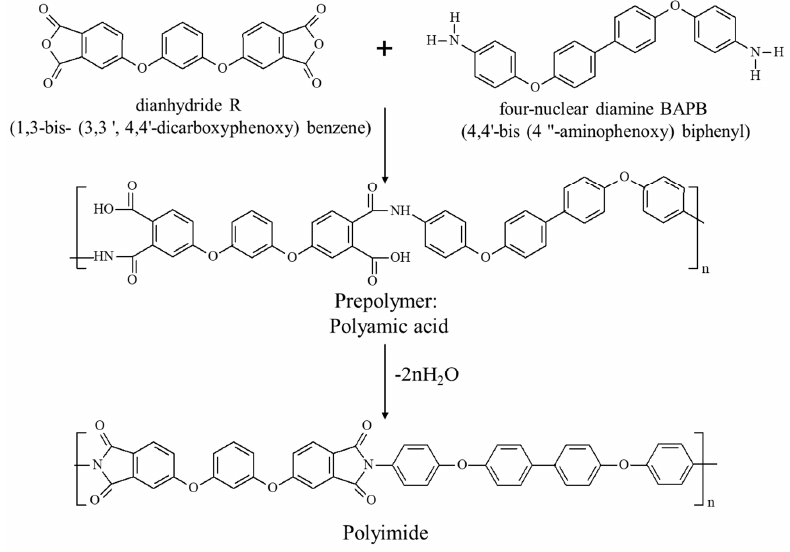
Figure 1. Synthesis of PI R-BAPB.